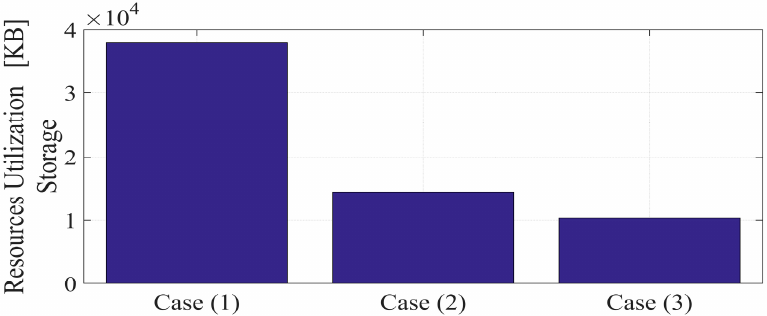
Table 3. The considered simulation cases.